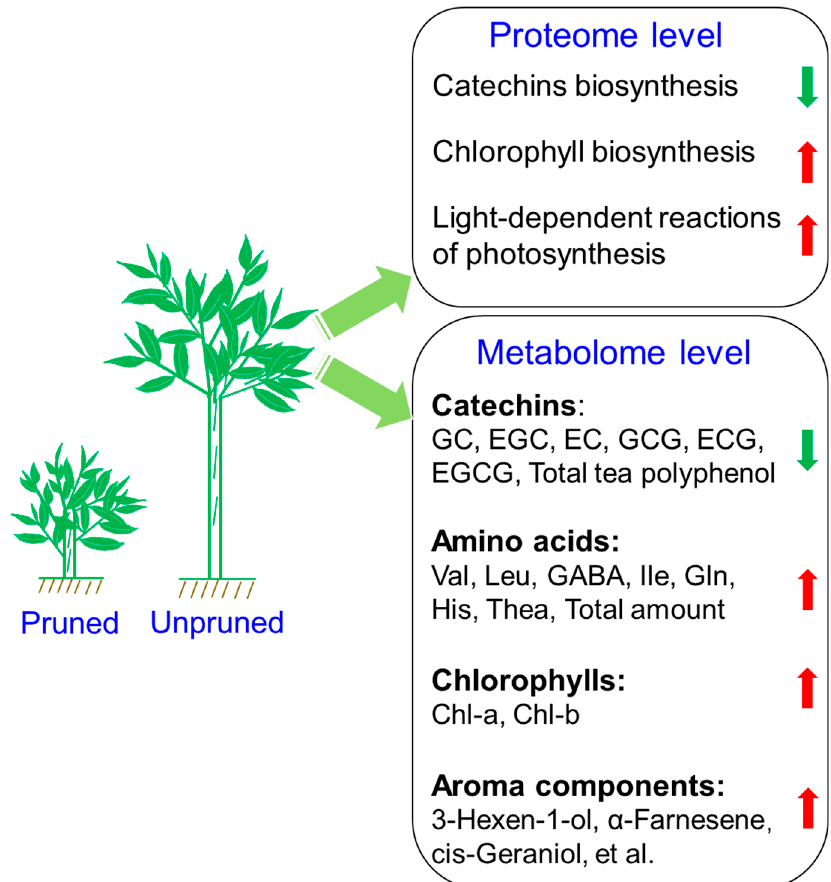
Figure 5. Summary on the formation of different quality constitutes in leaves of pruned and unpruned tea plants. Red arrow represents the increasing tendency in leaves from long-term unpruned ‘Dancong’ tea plant, while green represents the decreasing tendency.